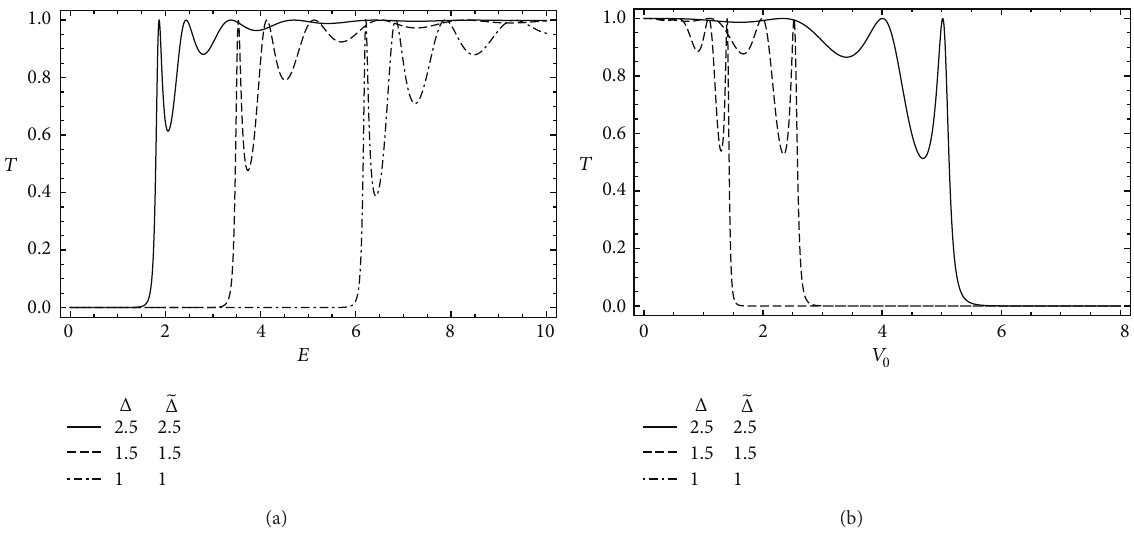
̃Δ ) on the transmission coefficient for 𝛼𝑥 0 = 20 , 𝛽̃𝑥 0 = 30 (large values of ̃Λ = 1 , 𝐴 = 𝐵 = 𝐶 = 𝐷 = 3 , and 𝑚 = 1 . (b) shows 𝑇 for varying 𝐸 = 3 , and 𝑚 = 1 . 0 ,